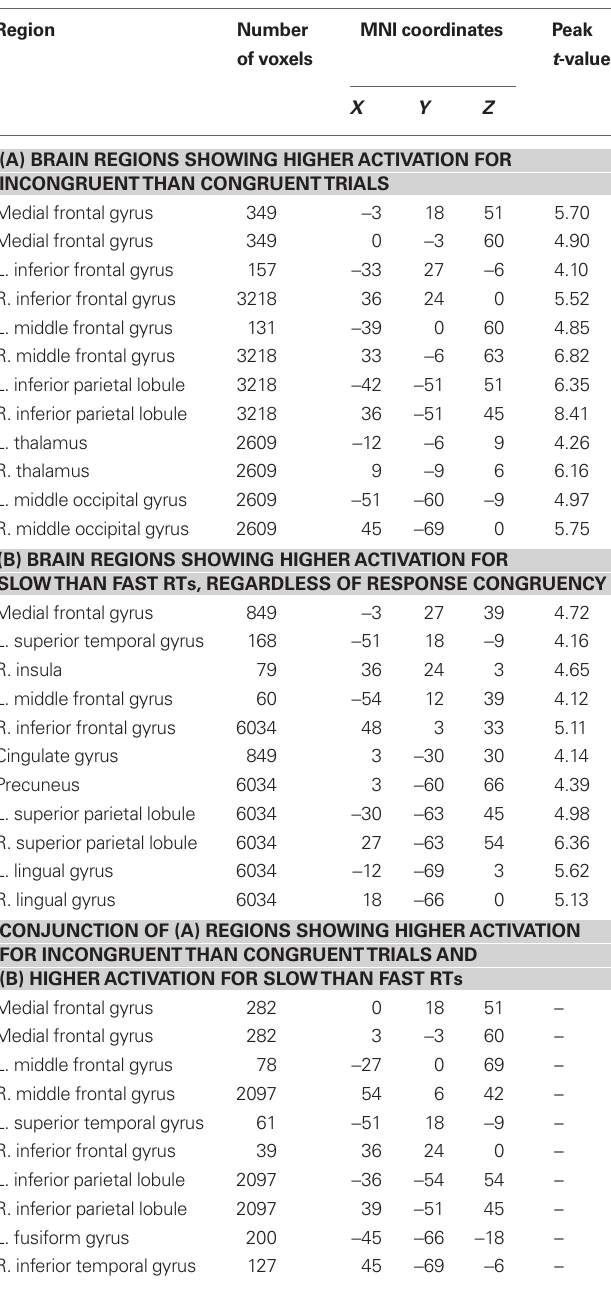
Table 1 | effects of congruency and RT on brain